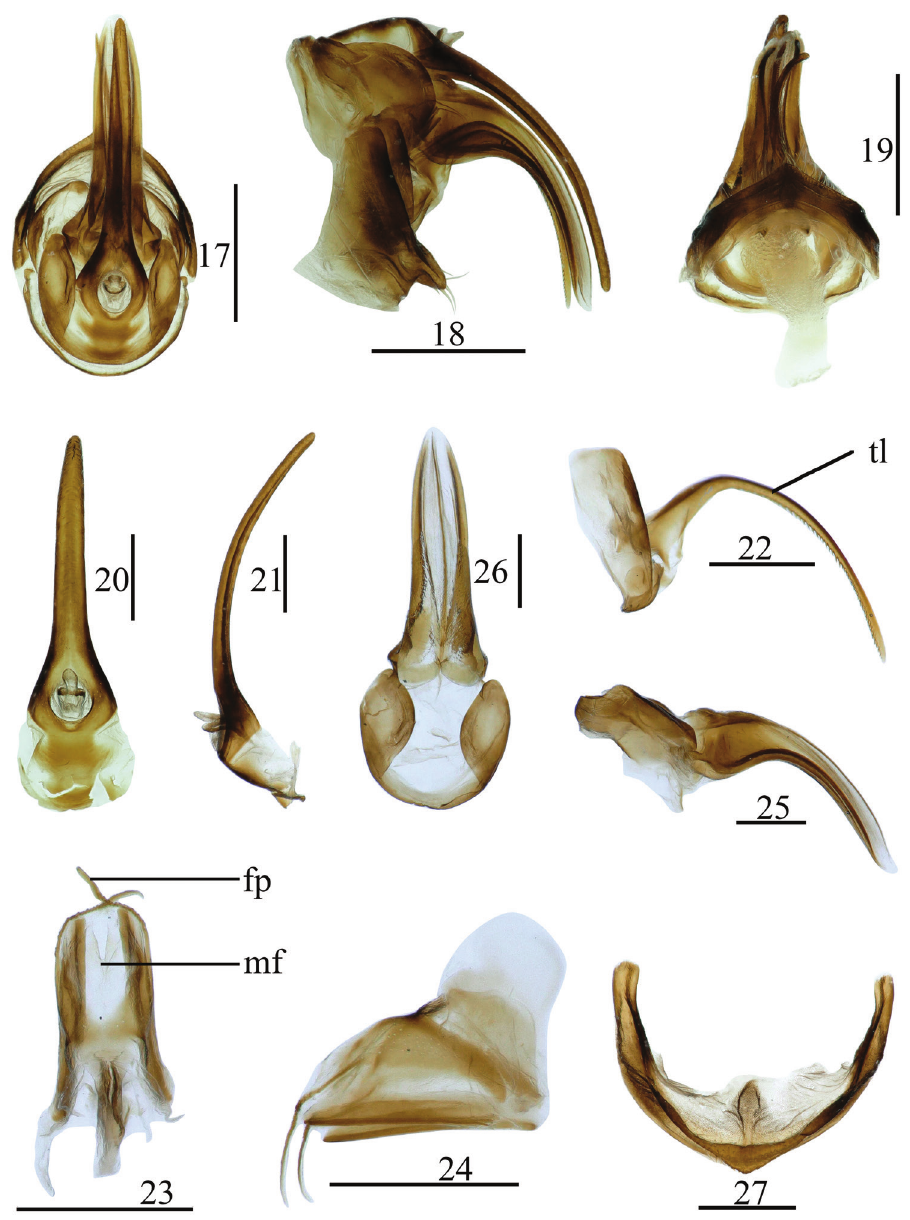
Figures 17–27. Tempsarima bipunctata Chang & Chen, sp. nov. 17 female genitalia, dorsal view 18 same, lateral view 19 same, ventral view 20 female anal segment, dorsal view 21 same, lateral view 22 anterior connective lamina of gonapophyses VIII, lateral view 23 posterior connective lamina of gona- pophyses IX, dorsal view 24 same, lateral view 25 gonoplacs, lateral view 26 same, dorsal view 27 sternite VII, ventral view. Scale bars: 1 mm ( 17–19 ), 0.5 mm ( 20–27 ). Abbreviations: tl–teeth in inner lateral margin, mf–median field, fp–flagelliform